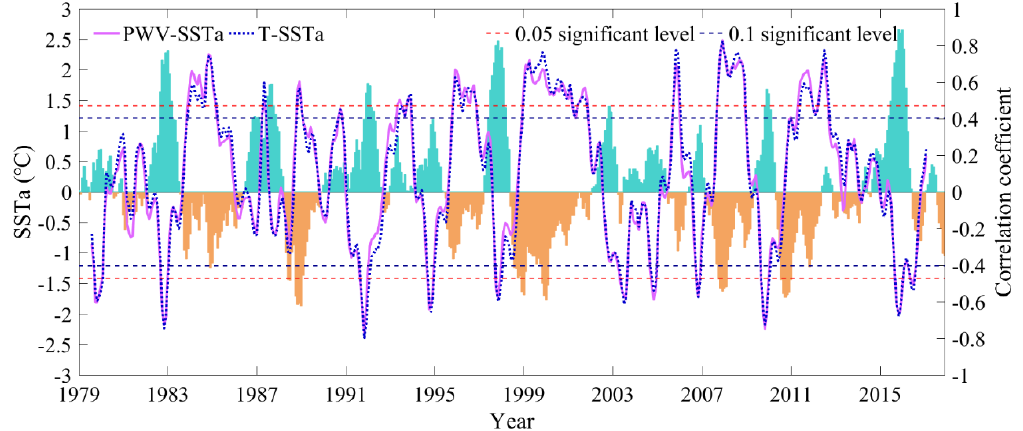
Figure 4. Correlation coefficient between PWV and T and SSTA in Southeast China over the period of 1979–2017.